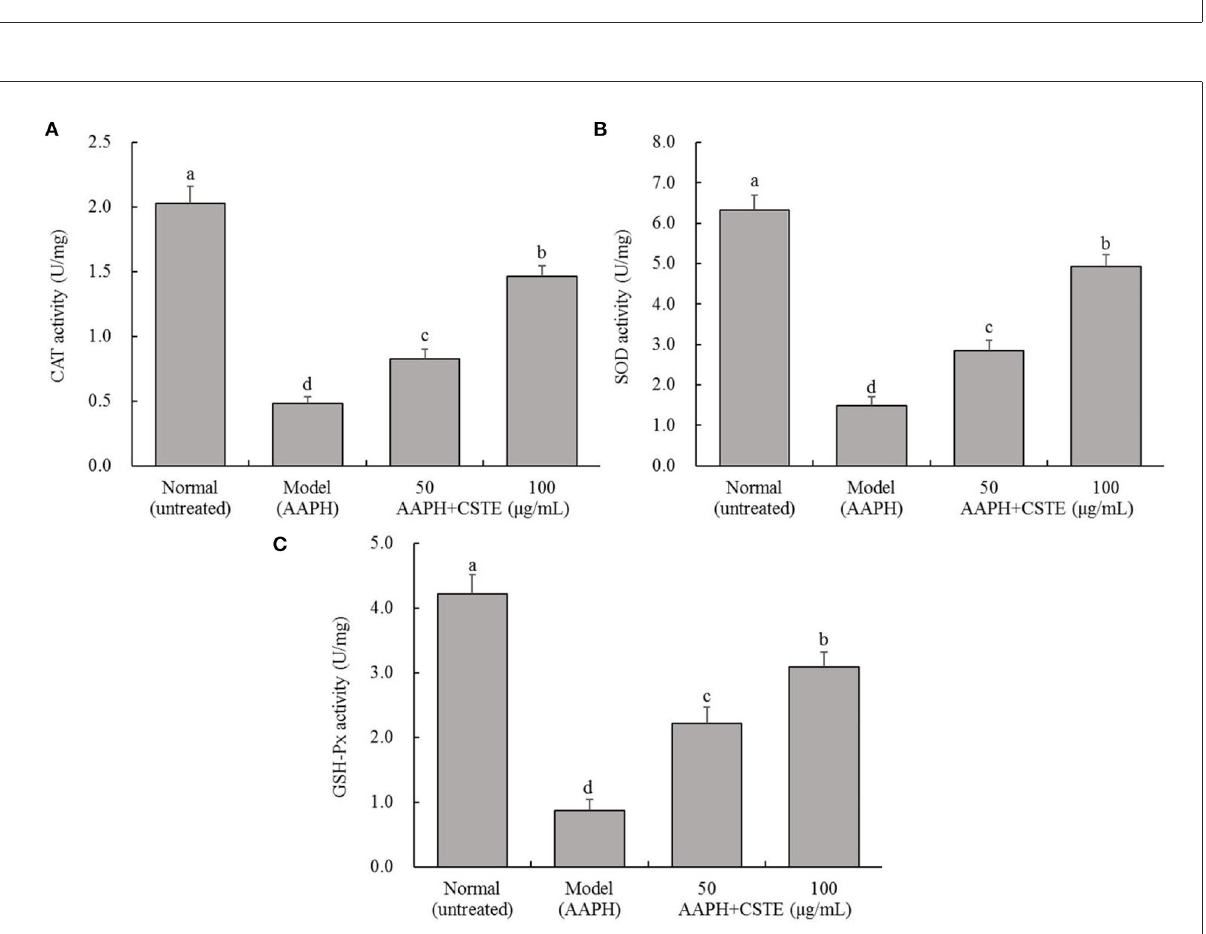
FIGURE4 CAT, SOD, and GSH-Px activities of AAPH inducing oxidative damaged HL-1 cardiomyocytes, (A) CAT activity, (B) SOD activity, (C) GSH-Px activity; CSTE: Clerodendranthus spicatus (Thunb.) C. Y. Wu extract. a − d according to Duncan’s multi range test, the average values of different letters in the same column have significant differences ( P < 0.05, n =